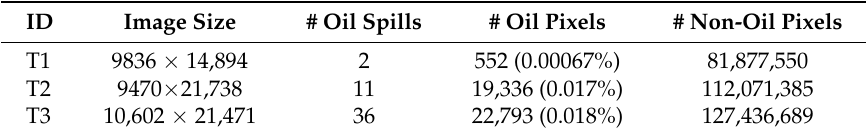
Table 3. Further details on D test , i.e., the three SAR products used as test set. The image size is reported as the number of